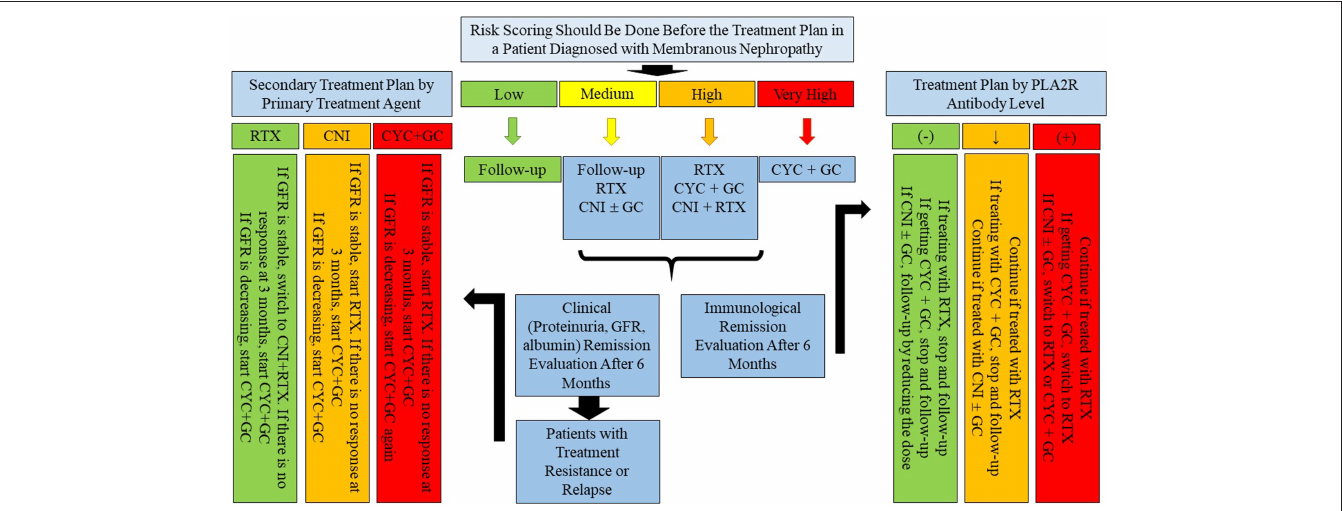
Figure 1. Membranous nephropathy follow-up and treatment chart. CNI, calcineurin inhibitor; CYC, cyclophosphamide; GC, glucocorticoid; GFR, glomerular filtration rate; PLA2R, anti-phospholipase A2 antibody; RTX,